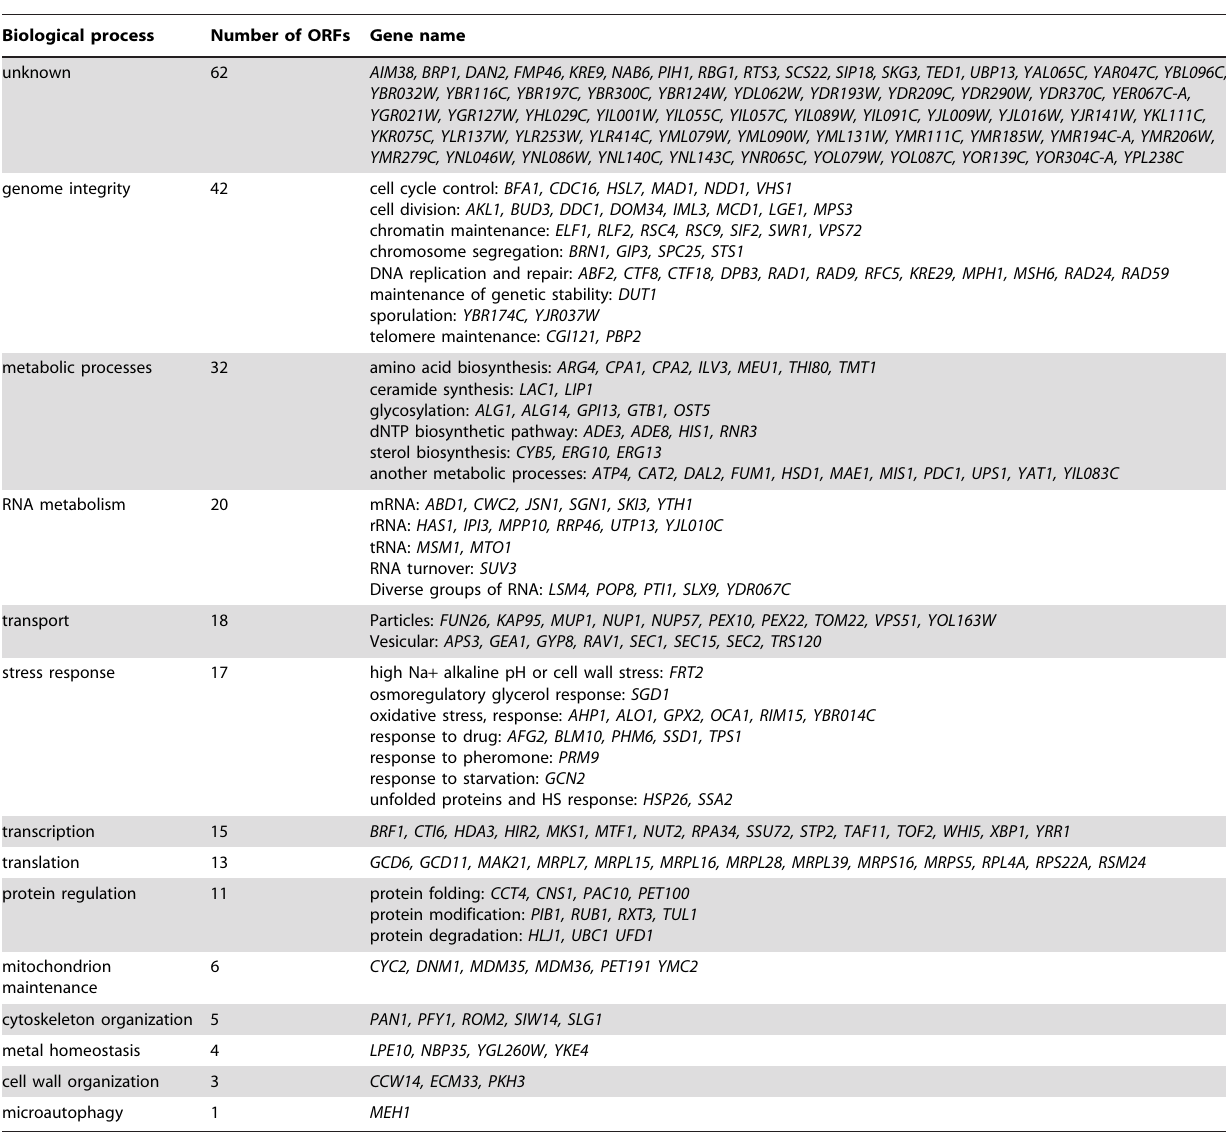
Table 1. 249 genes selected in SLM screens grouped on the basis of Biological Process functional